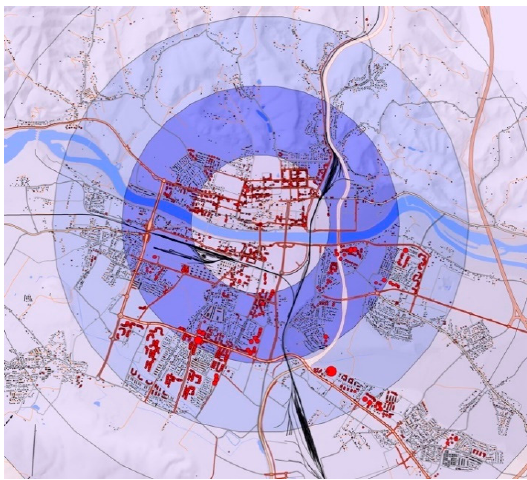
Figure 3. Population density according to the distance to the city center per 1 km (within 1st km—17,402 inhabitants; within 2nd km—30,441 inhabitants, within 3rd km—29,856 inhabitants, etc.) [32].